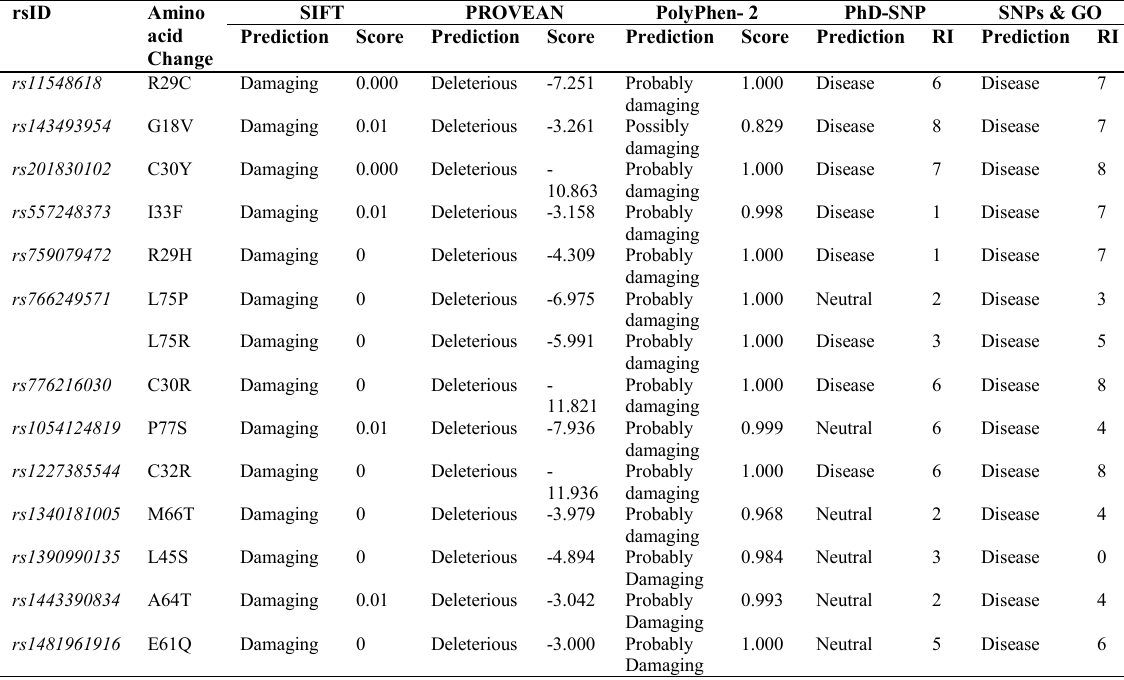
Table 1. Outputs for the most deleterious nsSNPs identified by the five in silico nsSNP prediction algorithms.